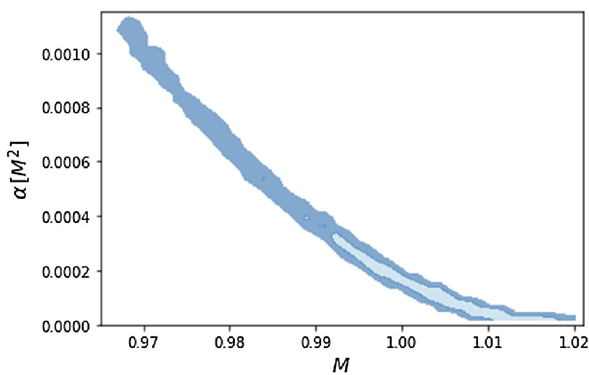
Fig. 2 1 σ and 2 σ parameter region of Born–Infeld f ( T ) black hole solution consistent with S2 star observations after a Monte–Carlo– Markov Chains